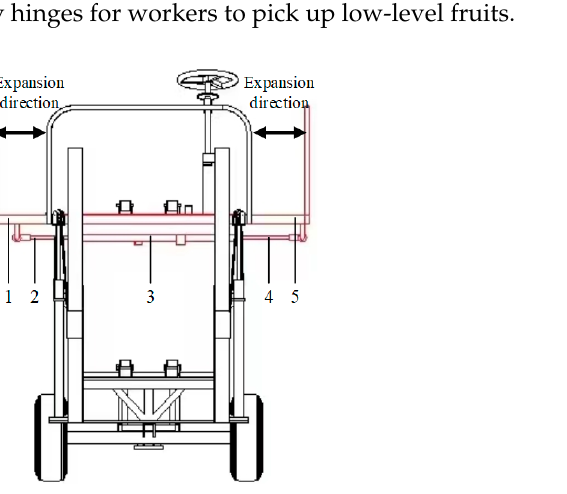
Figure 2. Structural diagram of the high-level expendable working platform. 1 and 5 represent the expansion pedals, 2 and 4 represent the hydraulic cylinders, and 3 represents the sliding rails.